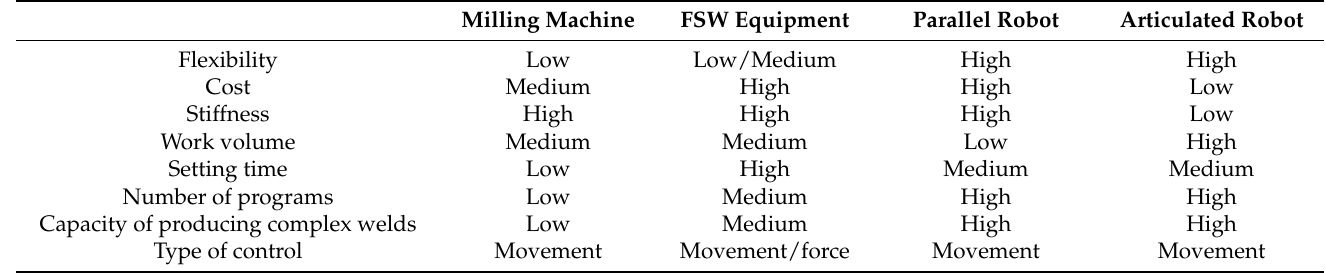
Table 3. Comparison between the milling machine and the equipment used for FSW welding.